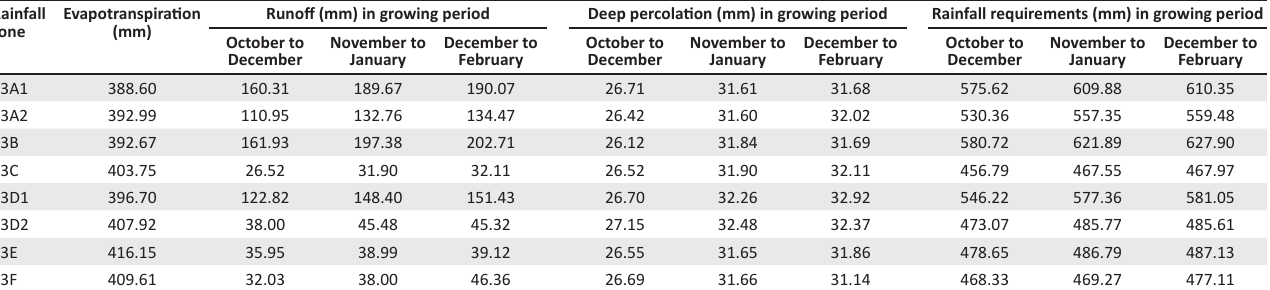
TABLE 2: Evapotranspiration, runoff, deep percolation and rainfall requirements of maize in specific growing periods in the eight rainfall zones. Rainfall Evapotranspiration zone